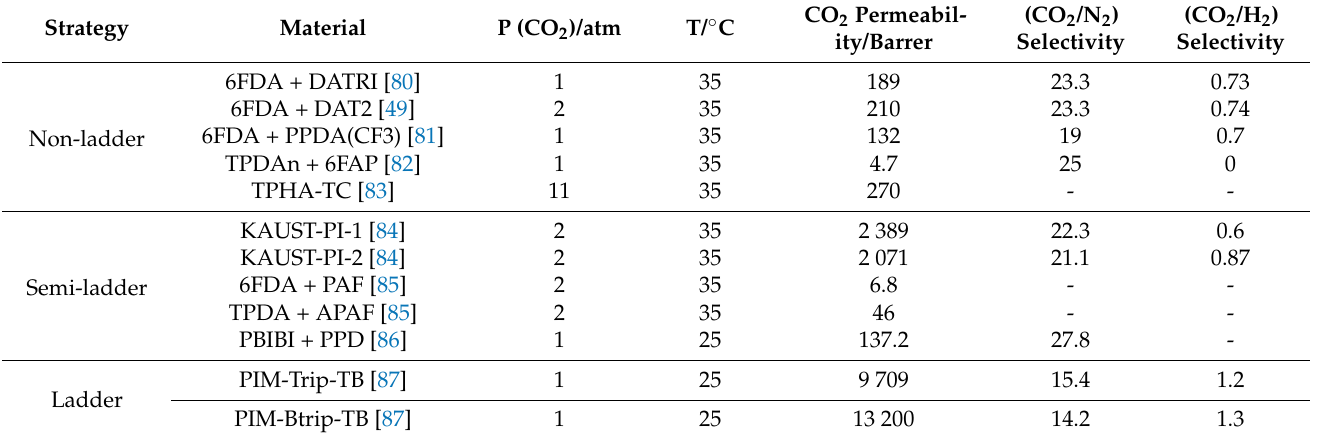
Table 6. Transport properties of specific iptycene-containing polymers.